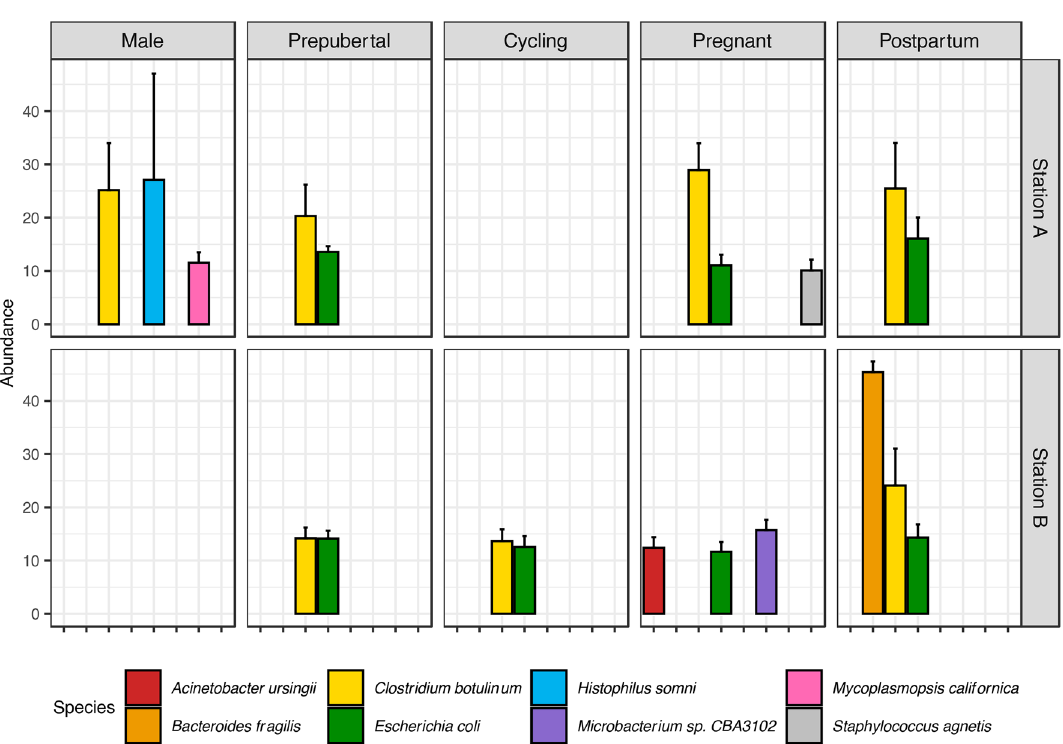
Figure 3. Species with more than 10% of abundance in the bovine reproductive metagenomes collected from Station A and Station B. Empty panels indicate no animal was sampled in that category and empty columns indicate species less than